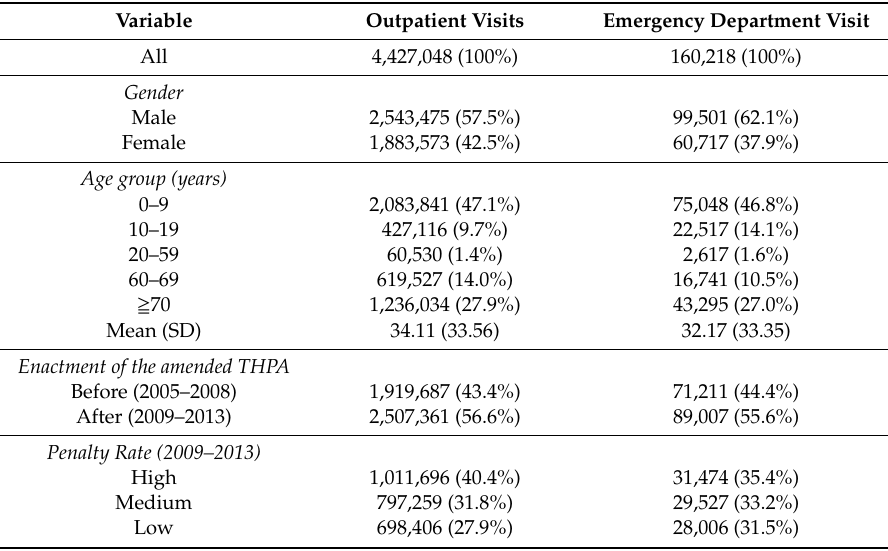
Table 1. Outpatient and emergency department visits for asthma,